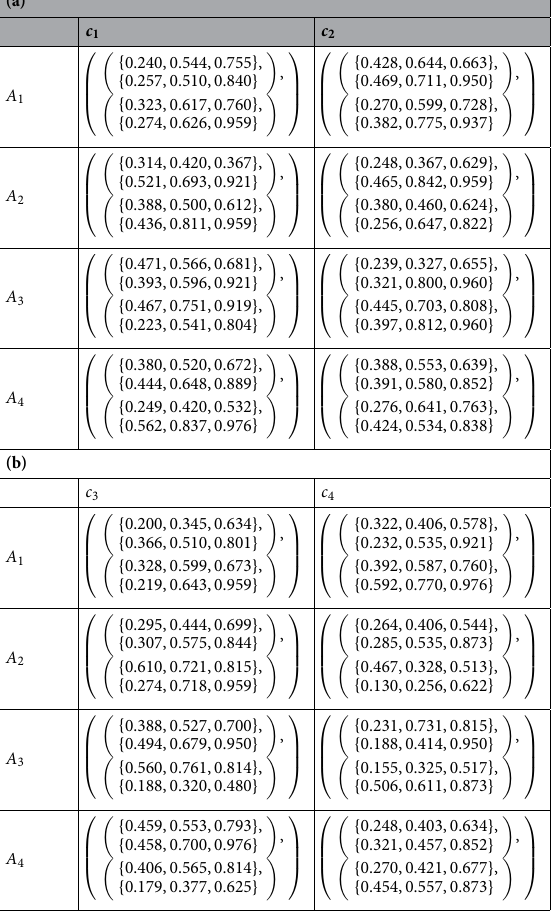
Table 5. Collective aggregation of FHFR